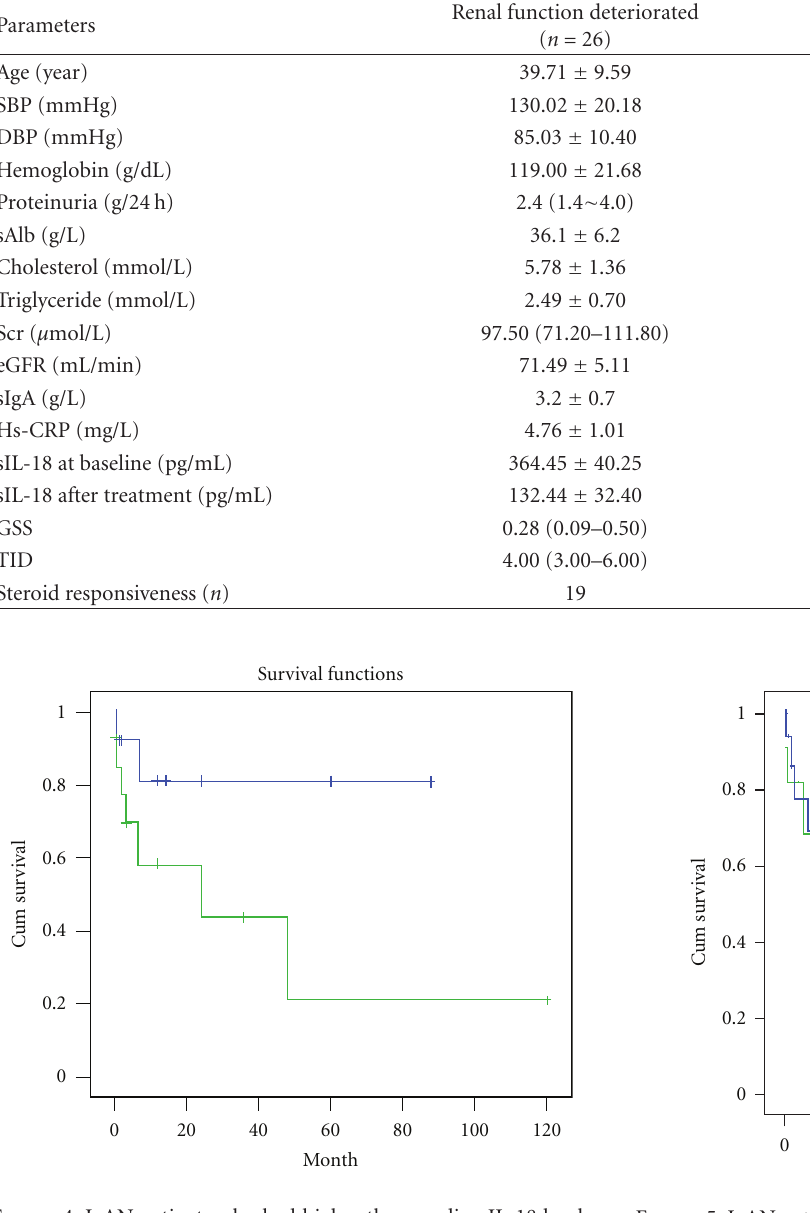
Figure 5: IgAN patients who had higher TID scores at baseline had worse renal outcome in follow-up period (Log rank P = 0 . 005). In this figure, green line represents those patients with higher TID